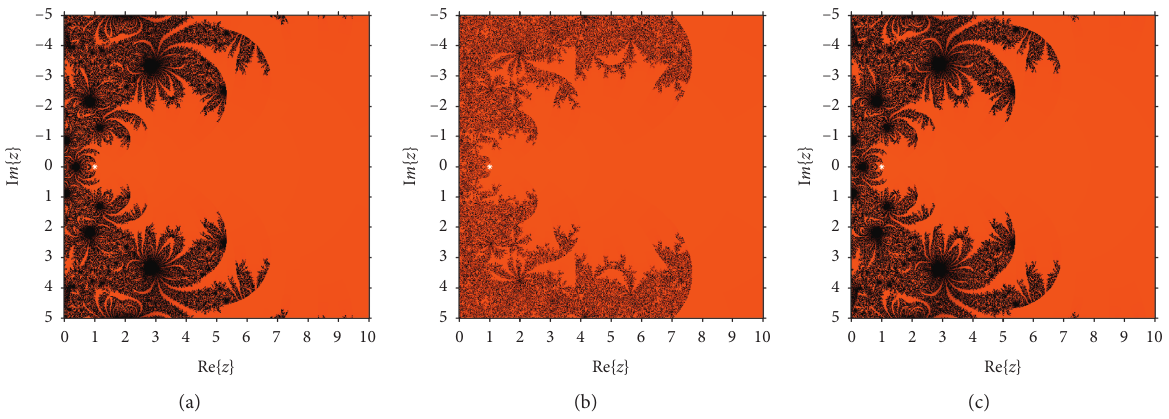
Figure 8: Basins of attraction of (a) SFM1, (b) SFM2, and (c) SFM3 for g